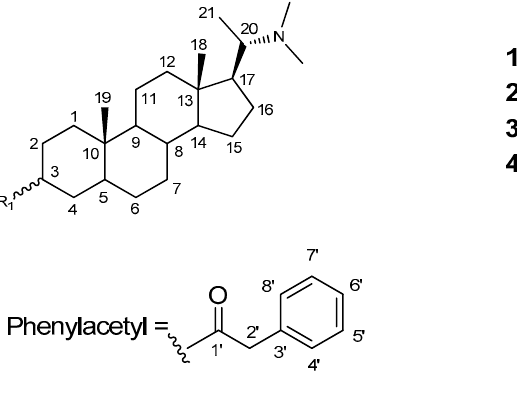
Figure 1. Structures of compounds 1 – 4 . Figure 2. Key 1 H, 1 H-COSY ( ), HMBC (H C), and ROESY ( ) correlations of compound 1 . Figure 3. Key 1 H, 1 H-COSY ( ), HMBC (H C), and ROESY ( ) correlations of compound 2 .